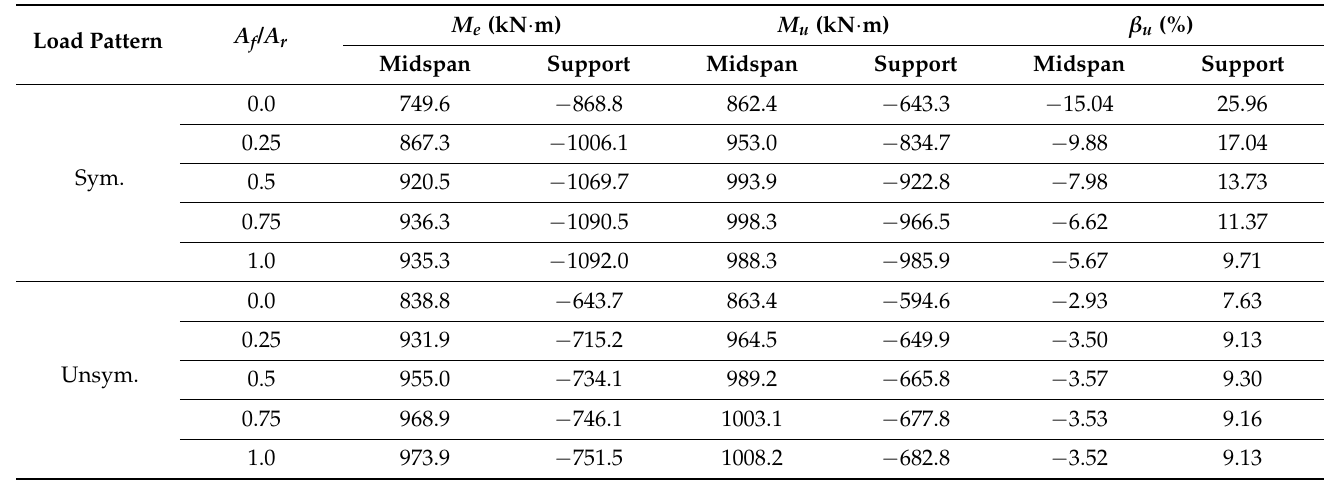
Table 1. Values of M e , M u and β u in beams with different hybrid levels under symmetri- cal/unsymmetrical loading.